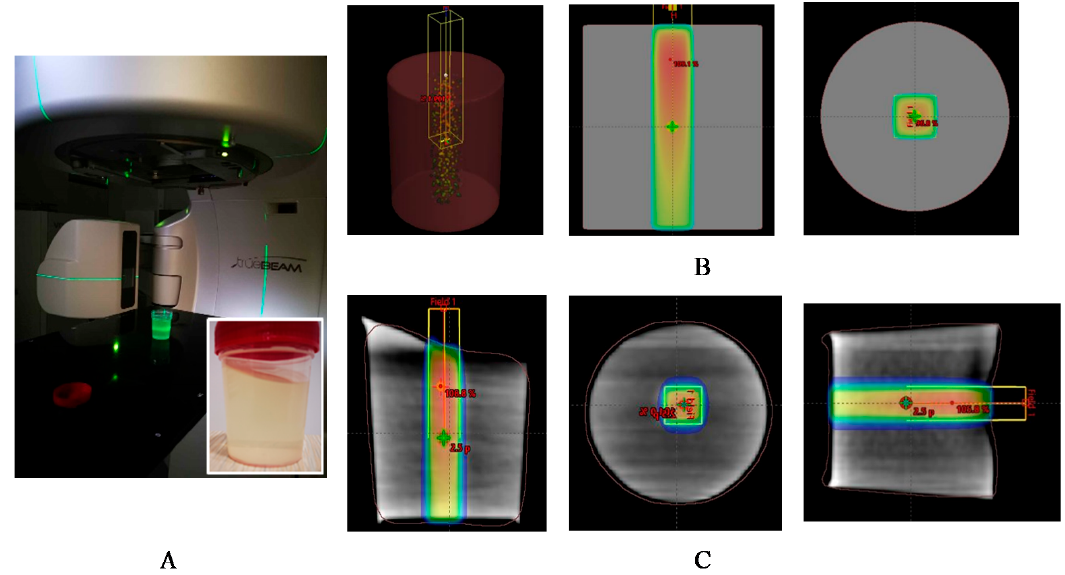
Figure 11. Irradiation of gel samples: ( A ) irradiation set up for small field irradiation of samples with a picture of freshly prepared gel-filled container before sealing; ( B ) small field beam irradiation plan calculated for water phantom by TPS Eclipse; and ( C ) small field beam irradiation plan calculated for real (gel) phantom with indicated dose distributions.